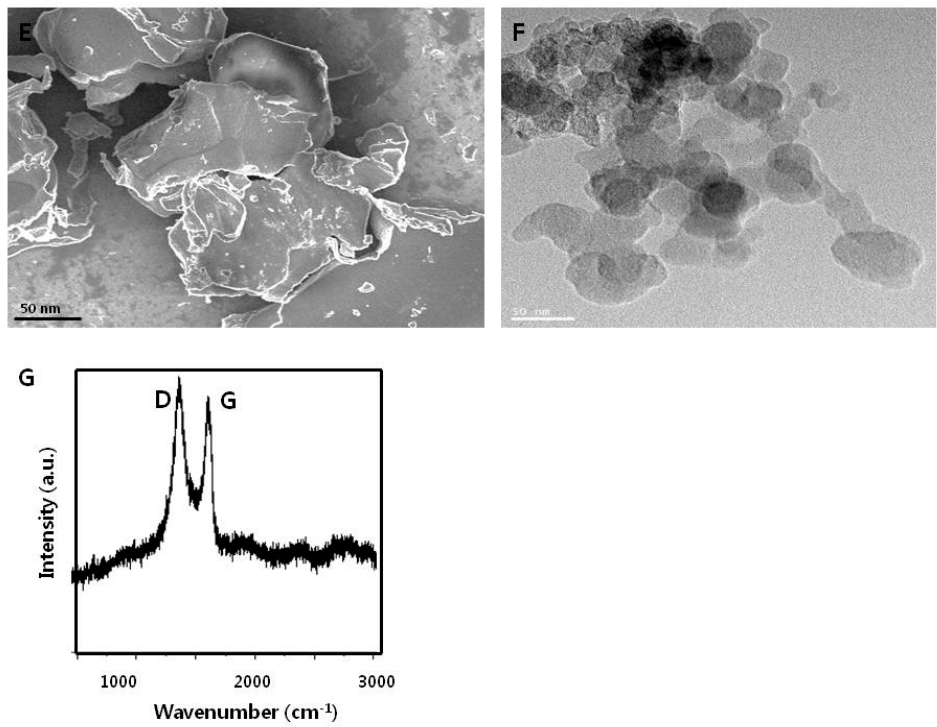
Figure 1. Synthesis and characterization of graphene oxide. ( A ) UV-visible spectrum of aqueous dispersions of graphene oxide. The absorption spectrum of graphene oxide exhibited a strong, broad peak at 230 nm. ( B ) FTIR spectrum of graphene oxide. ( C ) X-ray diffraction images of graphene oxide. ( D ) Dynamic light-scattering analysis of graphene oxide. ( E ) Scanning electron microscopy image of graphene oxide. ( F ) Transmission electron microscopy image of graphene oxide. ( G ) Raman spectrum of graphene oxide.